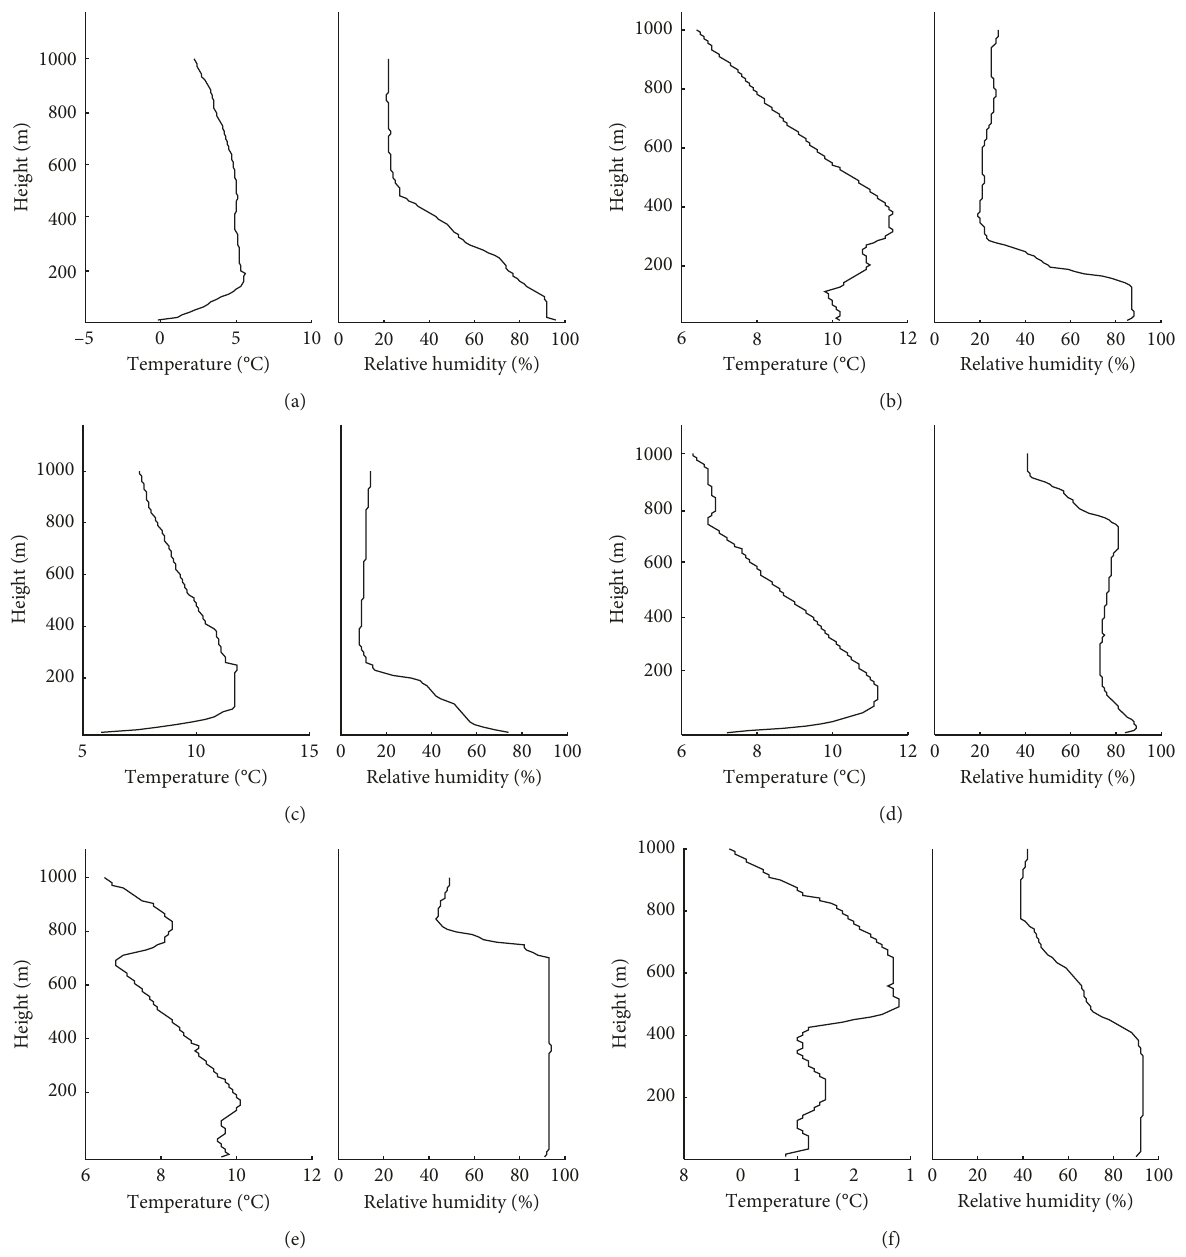
Figure 7: Vertical profiles of temperature and relative humidity at the Sheyang site from 1 to 9 December 2013: (a) 07:00 BTon 2 December, (b) 19:00 BTon 3 December, (c) 19:00 BTon 4 December, (d) 19:00 BTon 5 December, (e) 07:00 BTon 8 December, and (f) 19:00 BTon 8